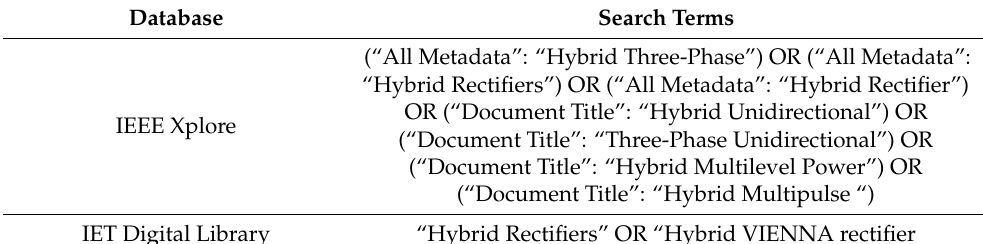
Table 1. String used in databases.